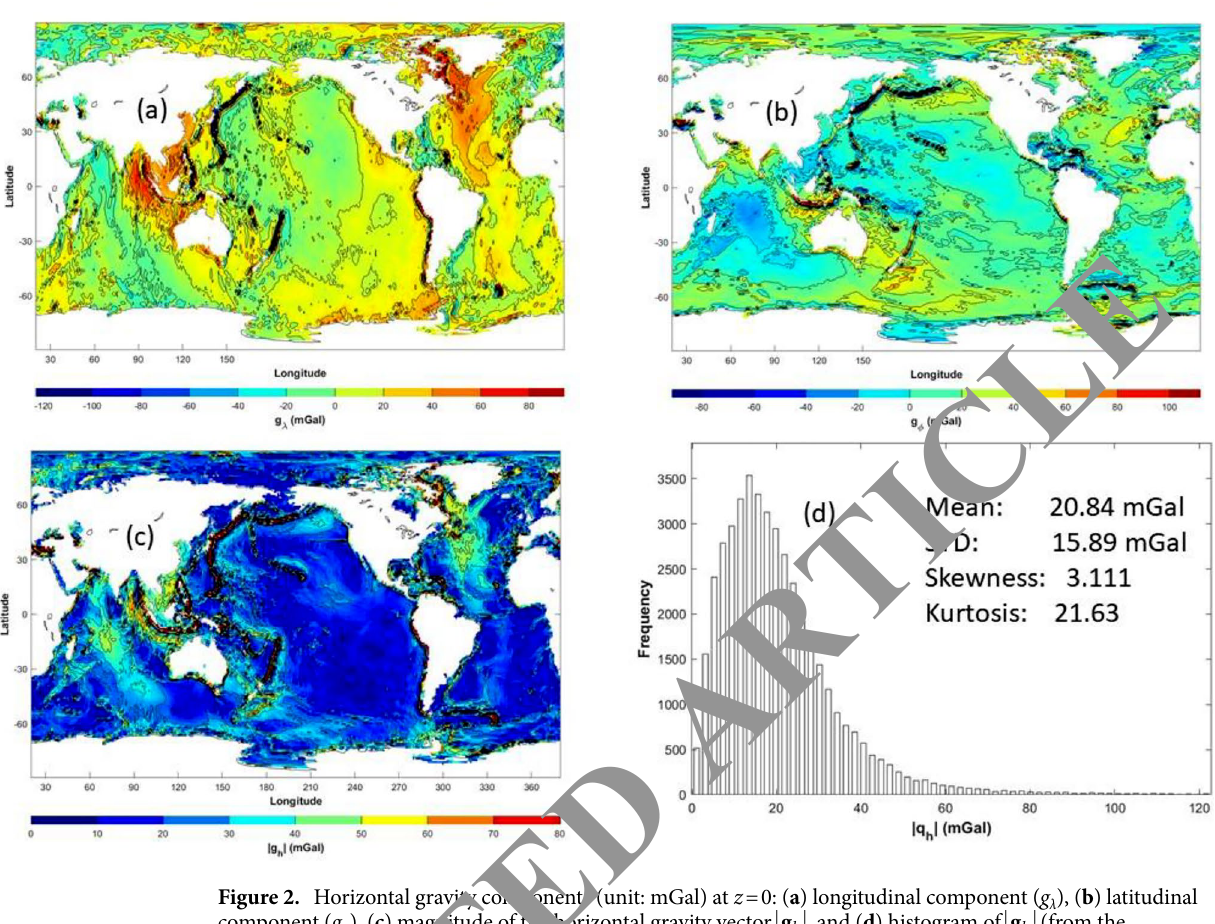
Figure 2. Horizontal gravity components (unit: mGal) at z = 0: ( a ) longitudinal component ( g λ ), ( b ) latitudinal component ( g φ ), ( c ) magnitude of the horizontal gravity vector reference 16 ). The source codes for the plots were written by the author ‘s research group using the Matlab Version R2019b (https:// www. mathw orks. com/ produ cts/ matlab. as shown in Fig. 2c. The histogram of | g h | (Fig. 2d) indicates a positively skewed distribution with a long tail extending to values larger than 100 mGal (1 mGal = 10 −5 m s −2 ). The statistical characteristics of | g h | are 20.84 mGal as the mean, 15.89 mGal as the standard deviation, 3.11 as the skewness, and 21.63 as the kurtosis. The statistical estimate of the mean intensity of the horizontal gravity | g h | (20.84 mGal) is coherent with the simple calculation of | g h | AB between points A and B (20.45 mGal). The two values (20.84 mGal, 20.45 mGal) are unex- pectedly large. C number to identify importance of the horizontal gravity.